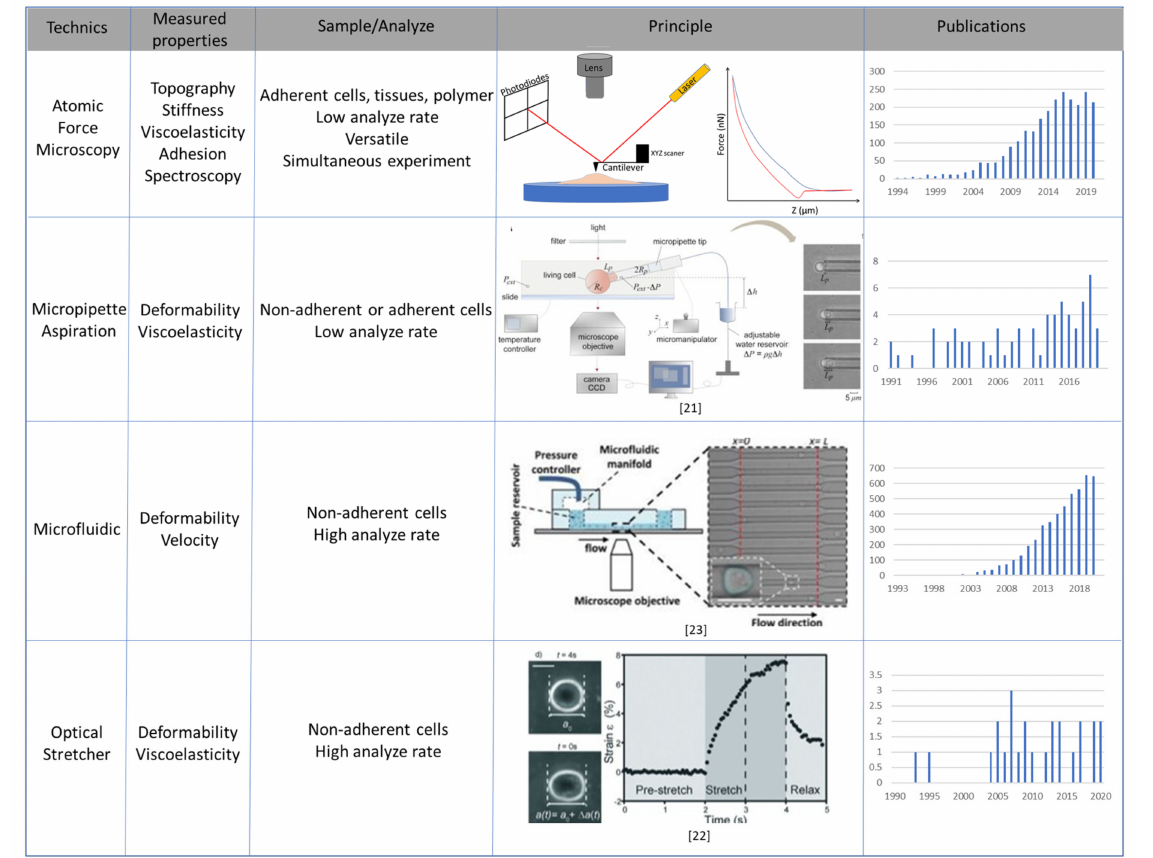
Figure 1. Overview of main techniques used to study cell or tissue biomechanical